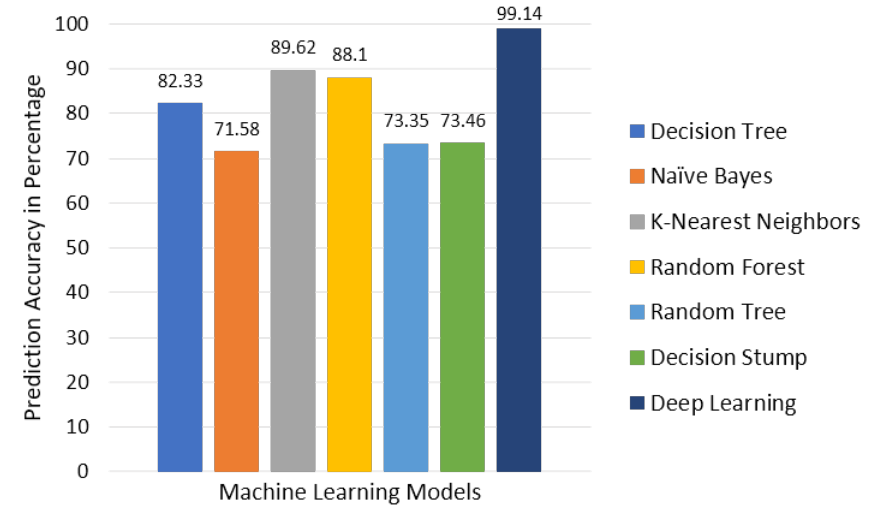
Figure 3. MIRA prediction accuracy with machine learning